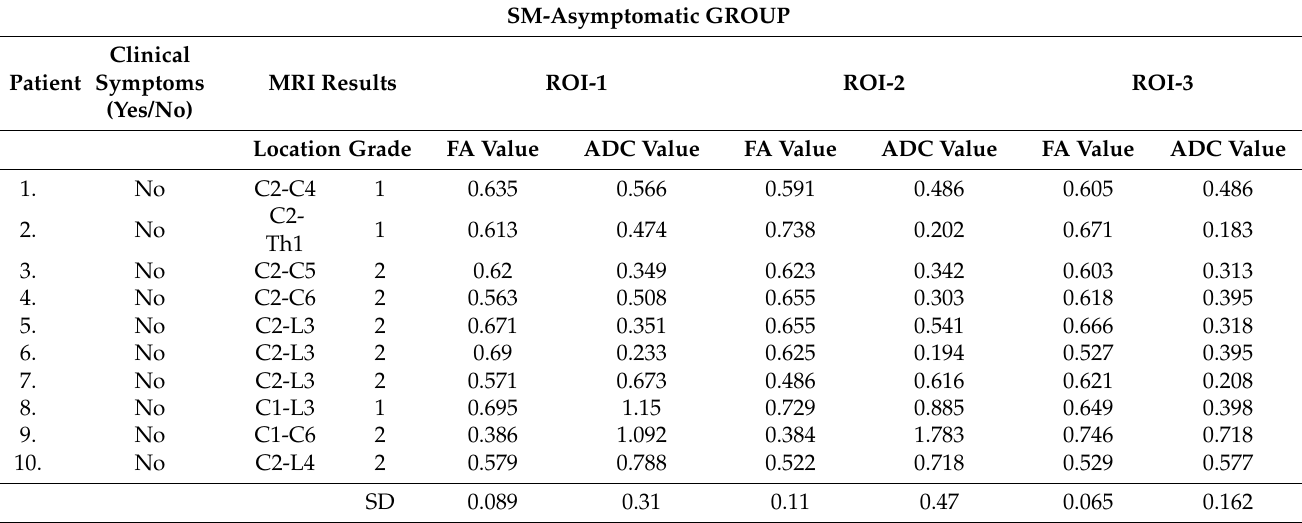
Table 2. Clinical and MRI results of the SM-asymptomatic group with FA and ADC measurements from ROI-1, ROI-2 and ROI-3.